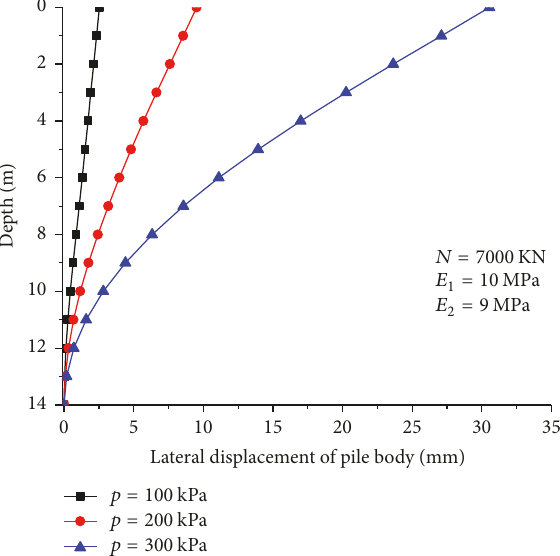
Figure 13: Relationship between lateral displacement of pile and 𝐸